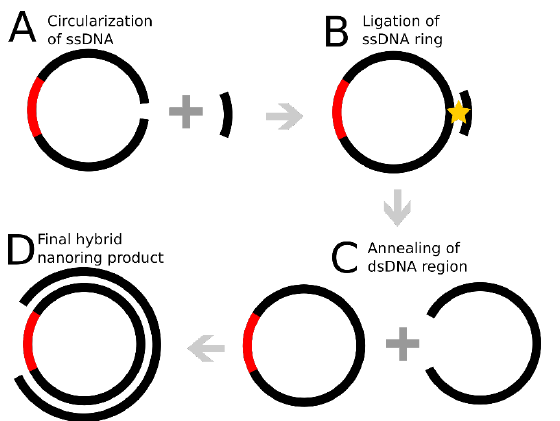
Figure 1. Nanoring circularization. ( A ) The ligation of the 190 nt ssDNA using a splinting oligonu- cleotide. ( B ) Ligation of the ring with T4 ligase. ( C ) Annealing of the 190 nt ring with the 160 nt ssDNA complement to yield the final ring construct, ( D ), in which 160 bp DNA duplex is connected through the 30 nt ssDNA segment marked with red.